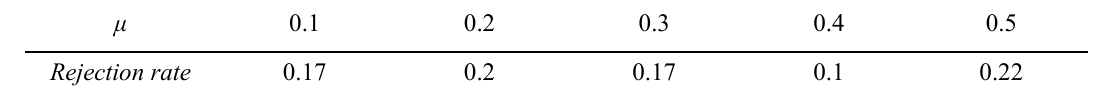
Table 11 . Rejection rates for alternative time discount in the fitness